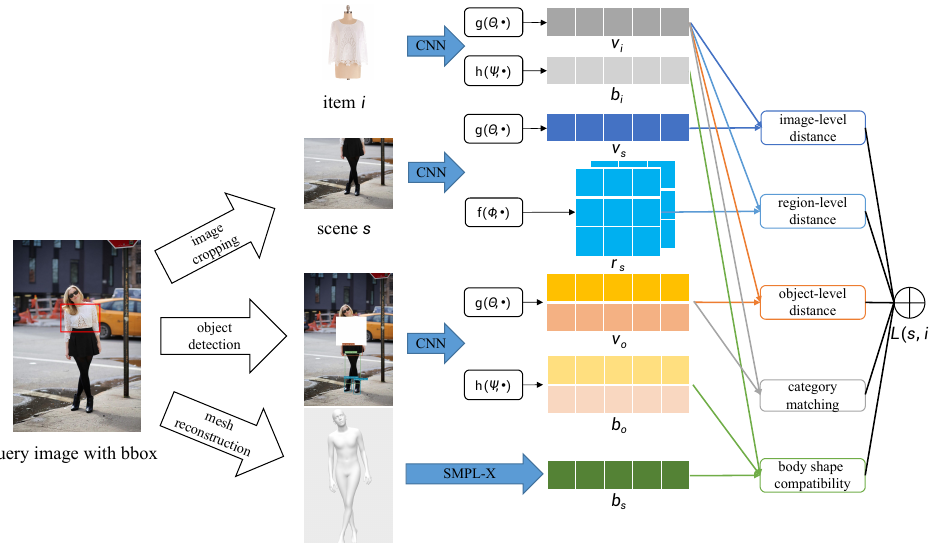
Figure 2. Overview of BOCTP through a simplified example. The left part shows the data-processing step, which contains three parts: image cropping, object detection and mesh reconstruction. The right part shows the training step. CNN denotes ResNet-50 pre-trained on the ImageNet dataset and SMPL-X denotes the extracted body-shape parameters. Embedding functions g ( Θ , · ) , f ( Φ , · ) and h ( Ψ , · ) are used to reduce the feature dimension and extract high-level representations (embedding vectors). In the shown example, the embedding vectors are of size 5, the feature map is of size 3 × 3 × 2 and the number of detected item objects is